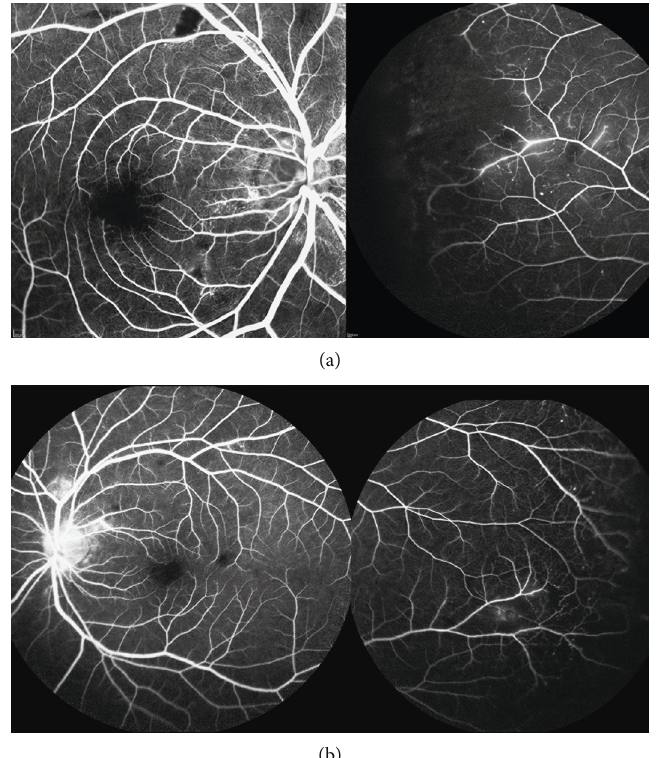
Figure 5: Case 2: fl uorescein angiography fi ndings at presentation. Asymmetric papillitis and occlusive vasculitis are seen in the (a) right and (b) left eyes.